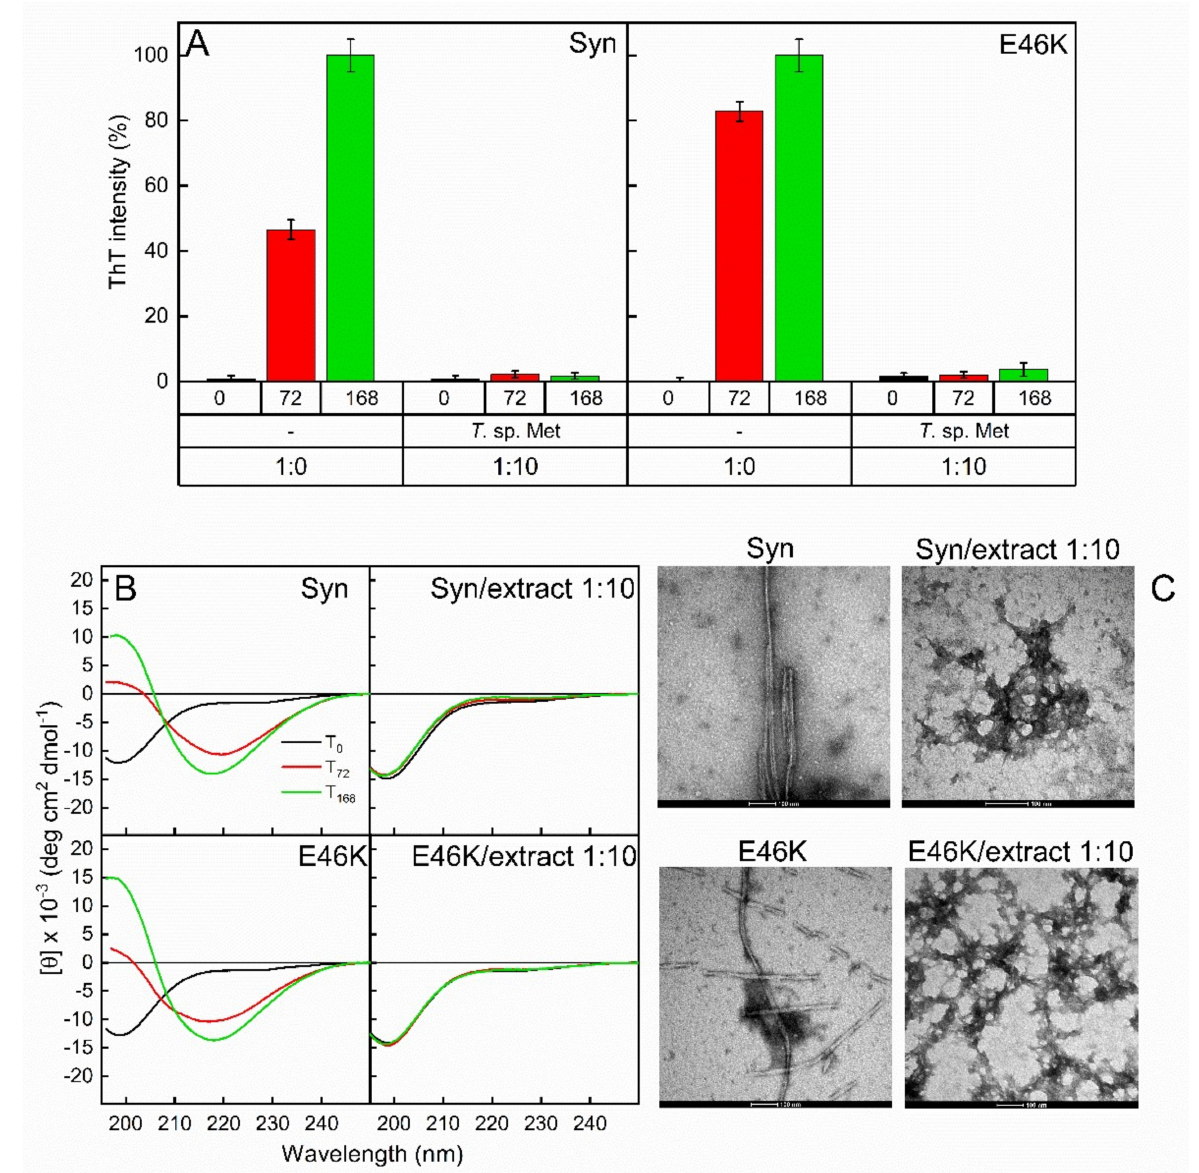
Figure 4. Amyloid formation inhibition probed by ThT fluorescence assay ( A ), circular dichroism (CD) ( B ) and TEM analysis ( C ). α -Synuclein (Syn) and its familial mutant (E46K) were left to aggregate in the absence (1:0) and in the presence (1:10) of methanol extract of Trametes sp. S2.OA.C_F6 ( T . sp. Met). Aliquots taken from the mixtures were collected after 0 (black), 72 (red) and 168 h (green) of incubation. The TEM scale bar in every picture corresponds to 100 nm. Error bars indicate the standard error of three independent experiments carried out in